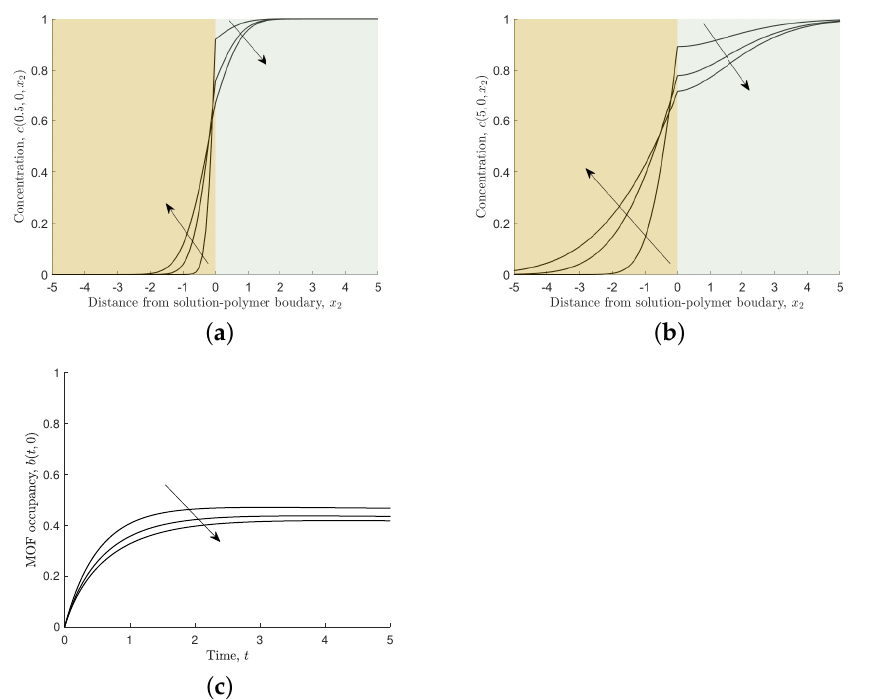
Figure 12. Results for different values of relative diffusion coefficient, D = 0.1,0.5,1, and s 1 = s 2 = s 3 = s 4 = 1. Arrows indicate the direction of increasing D . ( a , b ) Non-dimensional concentration of ferric ions through MOF mid-point across two media, c ( t ,0, x 2 ) at time t = 0.5 and 5, respectively. ( c ) Non-dimensional MOF occupancy, b ( t ,0 )